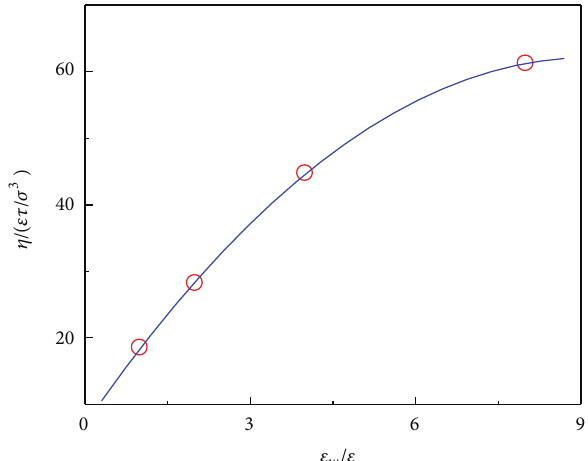
Figure 34: The shear viscosity of nonfunctional PFPE ( 𝜀 𝑝 𝑏 = 𝜀 𝑝 𝑤 = 0 ) films with the thickness of 3𝜎 as a function of surface interactions ( 𝜀 𝑤 ) at the shear rate of 0.1𝜏 −1 . Note that 230 functional PFPEs with = 10 are confined in the unit cell of 30𝜎 × 30𝜎 × 3𝜎 . 𝑁 𝑝